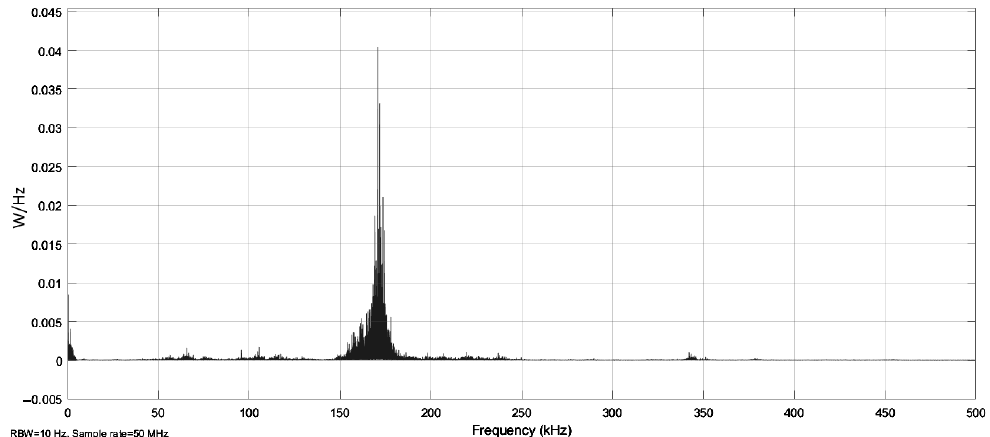
Figure 14. Baseband spectrum of the transmitter output chaotic signal, modulated with random bit sequence.